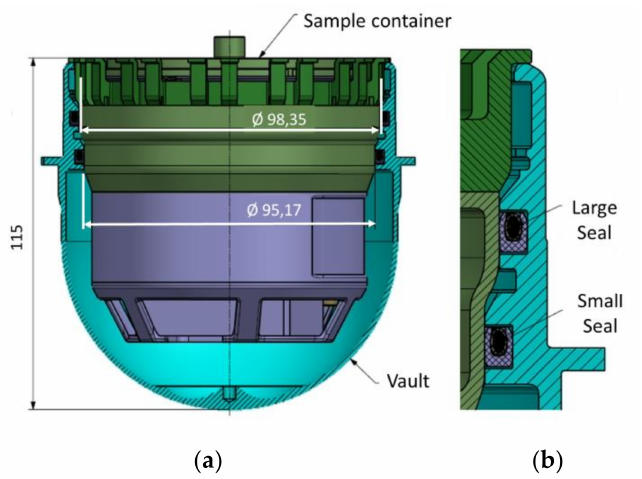
Figure 8. Vault closed with the SC: ( a ) section, ( b ) detail in the sealing